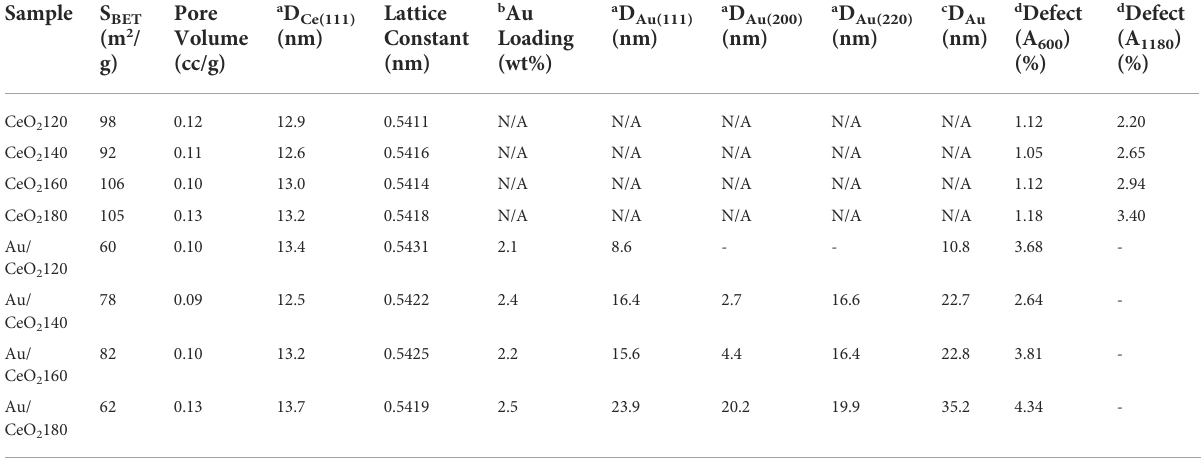
TABLE 1 Physicochemical properties of the synthesized CeO 2 X supports and Au/CeO 2 X catalysts.